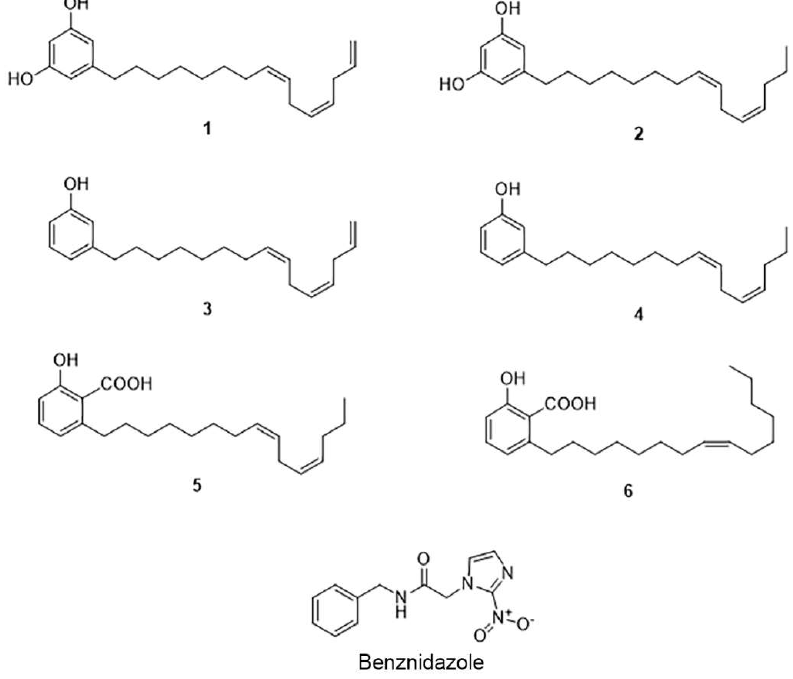
Figure 1 . Structure of the isolated compounds and benznidazole . Figure 1. Structure of the isolated compounds and